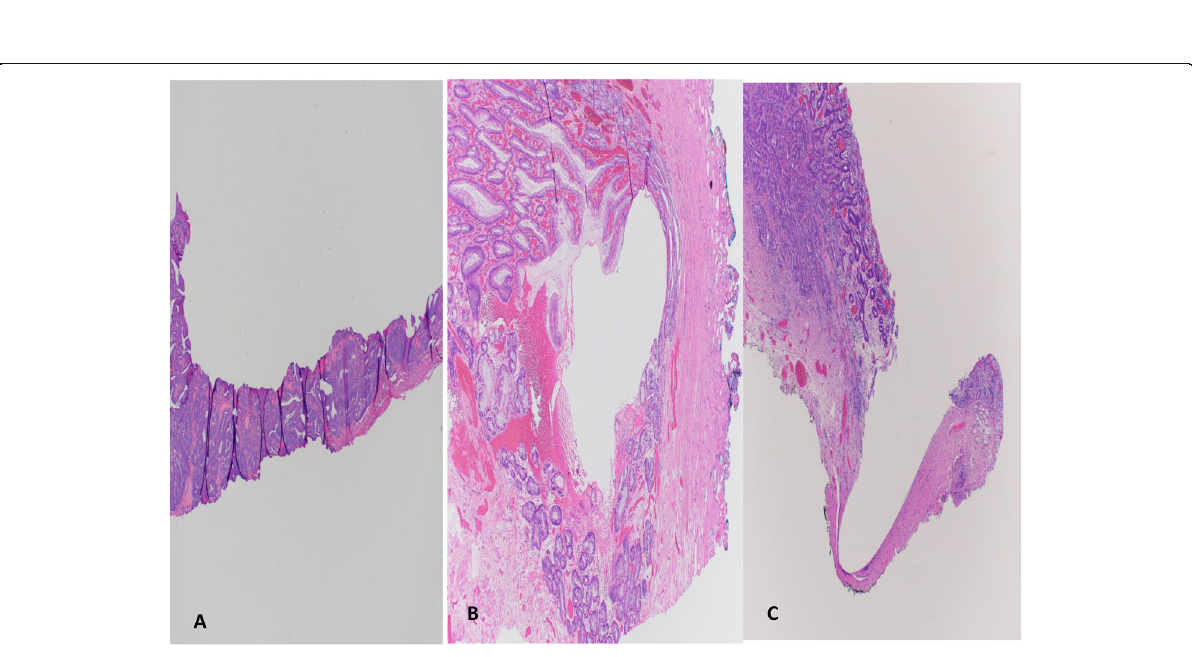
Fig. 5 A . Tissue folding artefact due to improper processing and embedding. Hematoxylin and Eosin stain × 20. B . Pinhole artefact causing curling of tissue at edges leading to difficulty in peripheral margin interpretation. Hematoxylin and Eosin stain. × 40. C . Large pinhole artefact causing disruption of tissue at the edge. ×